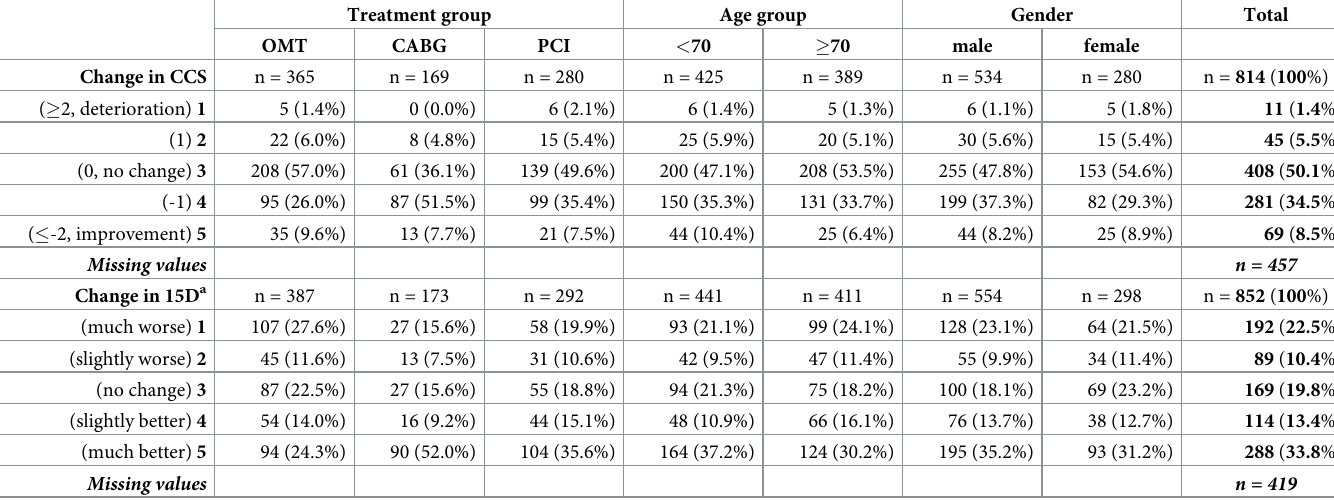
Table 3. Changes in the CCS and 15D from baseline to 12 months follow-up by subgroups. The values are n